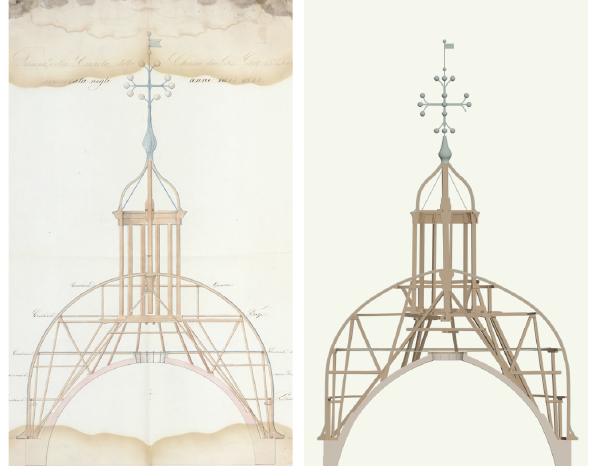
Figure 11. Comparison between the historical section (1850s) and the actual one obtained with a laser scanning survey.